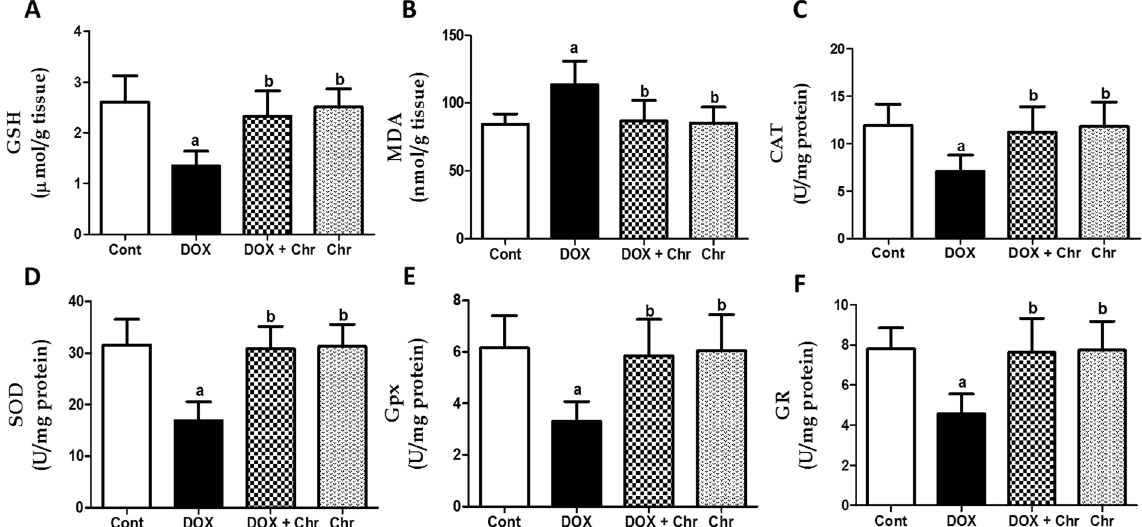
Figure 3. Effect of chrysin on oxidative stress markers and antioxidant enzymes in rats subjected to chronic doxorubicin (DOX) intoxication. ( A ) GSH ( μ mol/g tissue). ( B ) MDA (nmol/g tissue). ( C ) CAT (U/mg protein). ( D ) SOD (U/mg protein). ( E ) Gpx (U/mg protein). ( F ) GR (U/mg protein). Data are represented as mean ± SD (n = 10). a or b: Statistically significant from the control or DOX group respectively at P < 0.05 using one-way analysis of variance ANOVA followed by Tukey-Kramer as a post-hoc